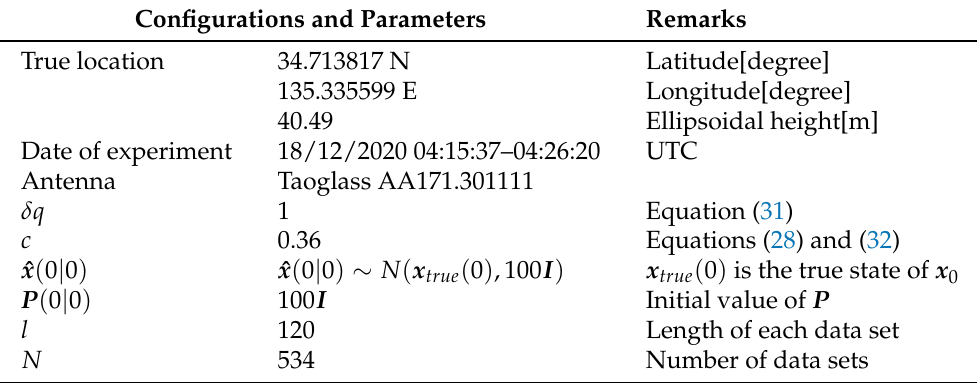
Table 4. Algorithm and experimental